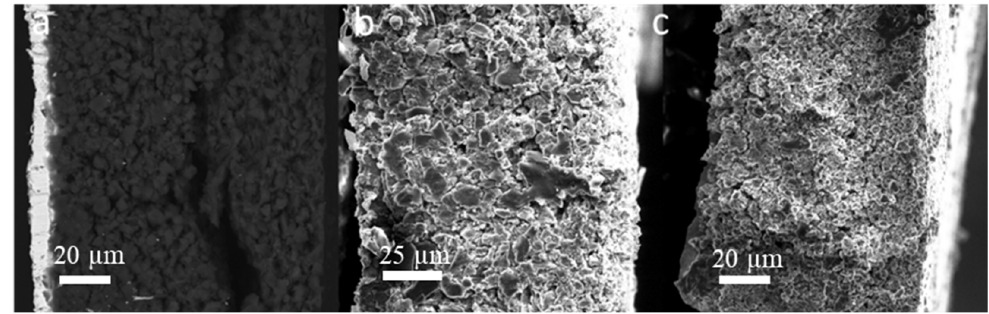
Figure 4. Cross-sectional SEM images of SF anodes after 100 cycles: ( a ) graphite, ( b ) hard carbon, and ( c ) soft carbon.